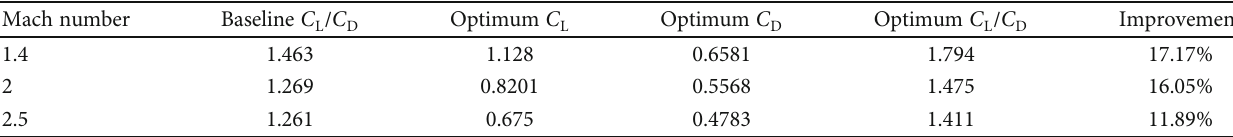
Figure 12: Optimization process. Table 3: Optimization results.